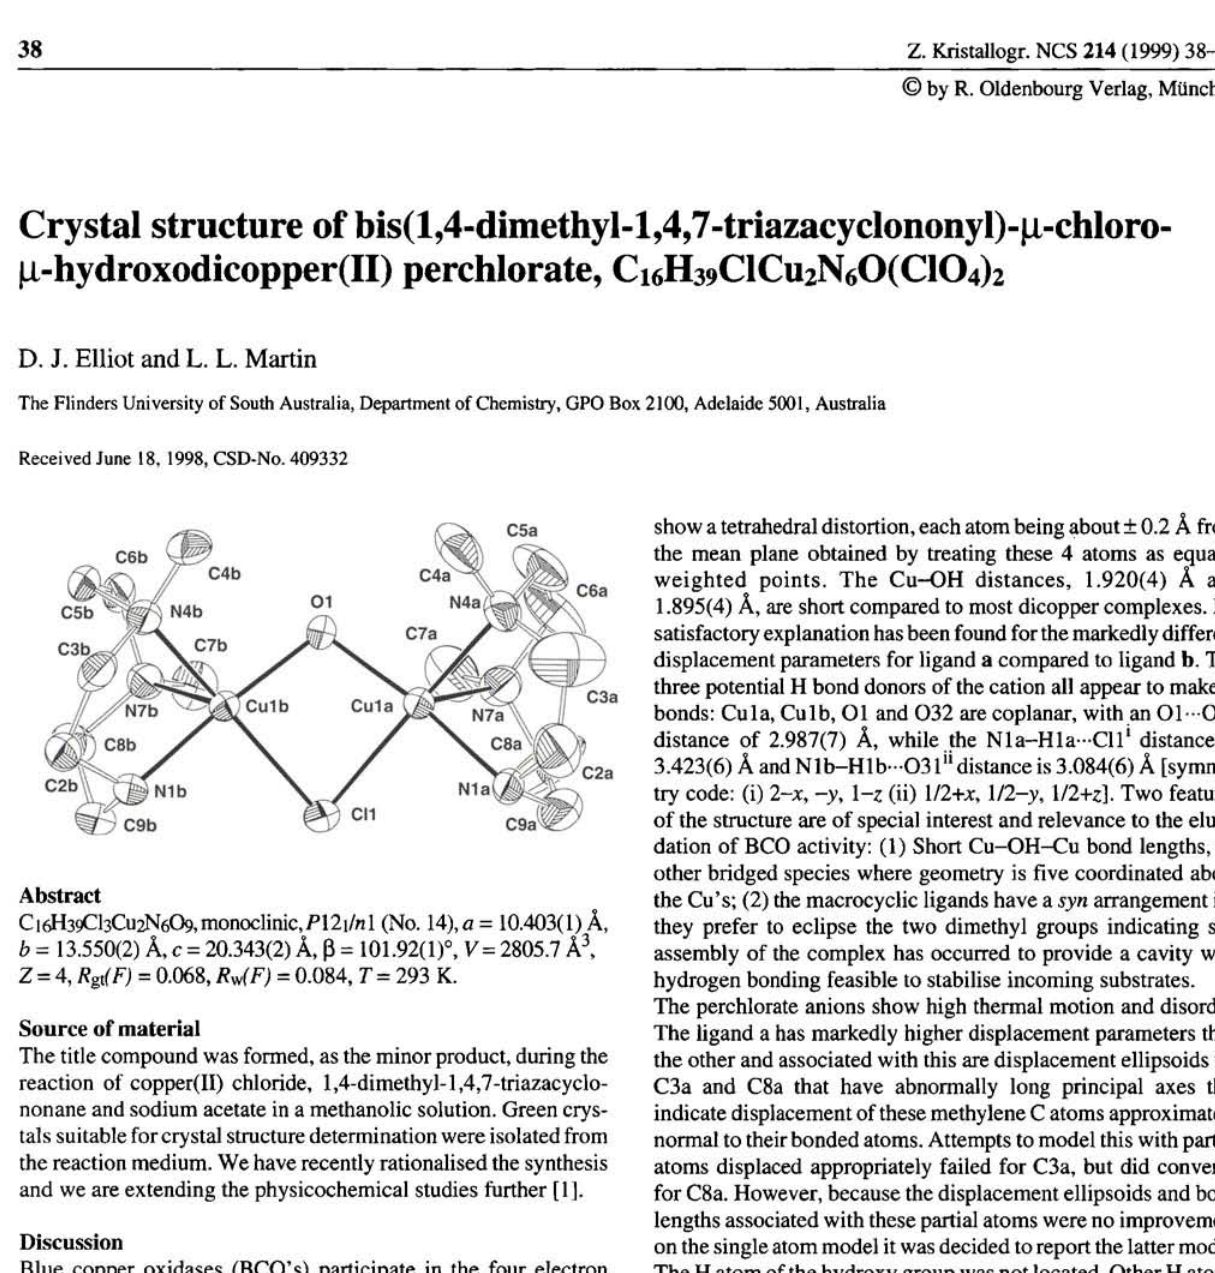
Table 1. Data collection and